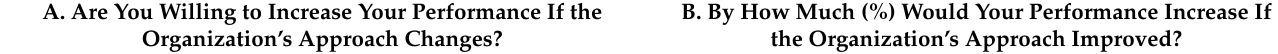
Table 4. The willingness of respondents to increase creative performance if the approach on the part of the organization changes (students’ responses).